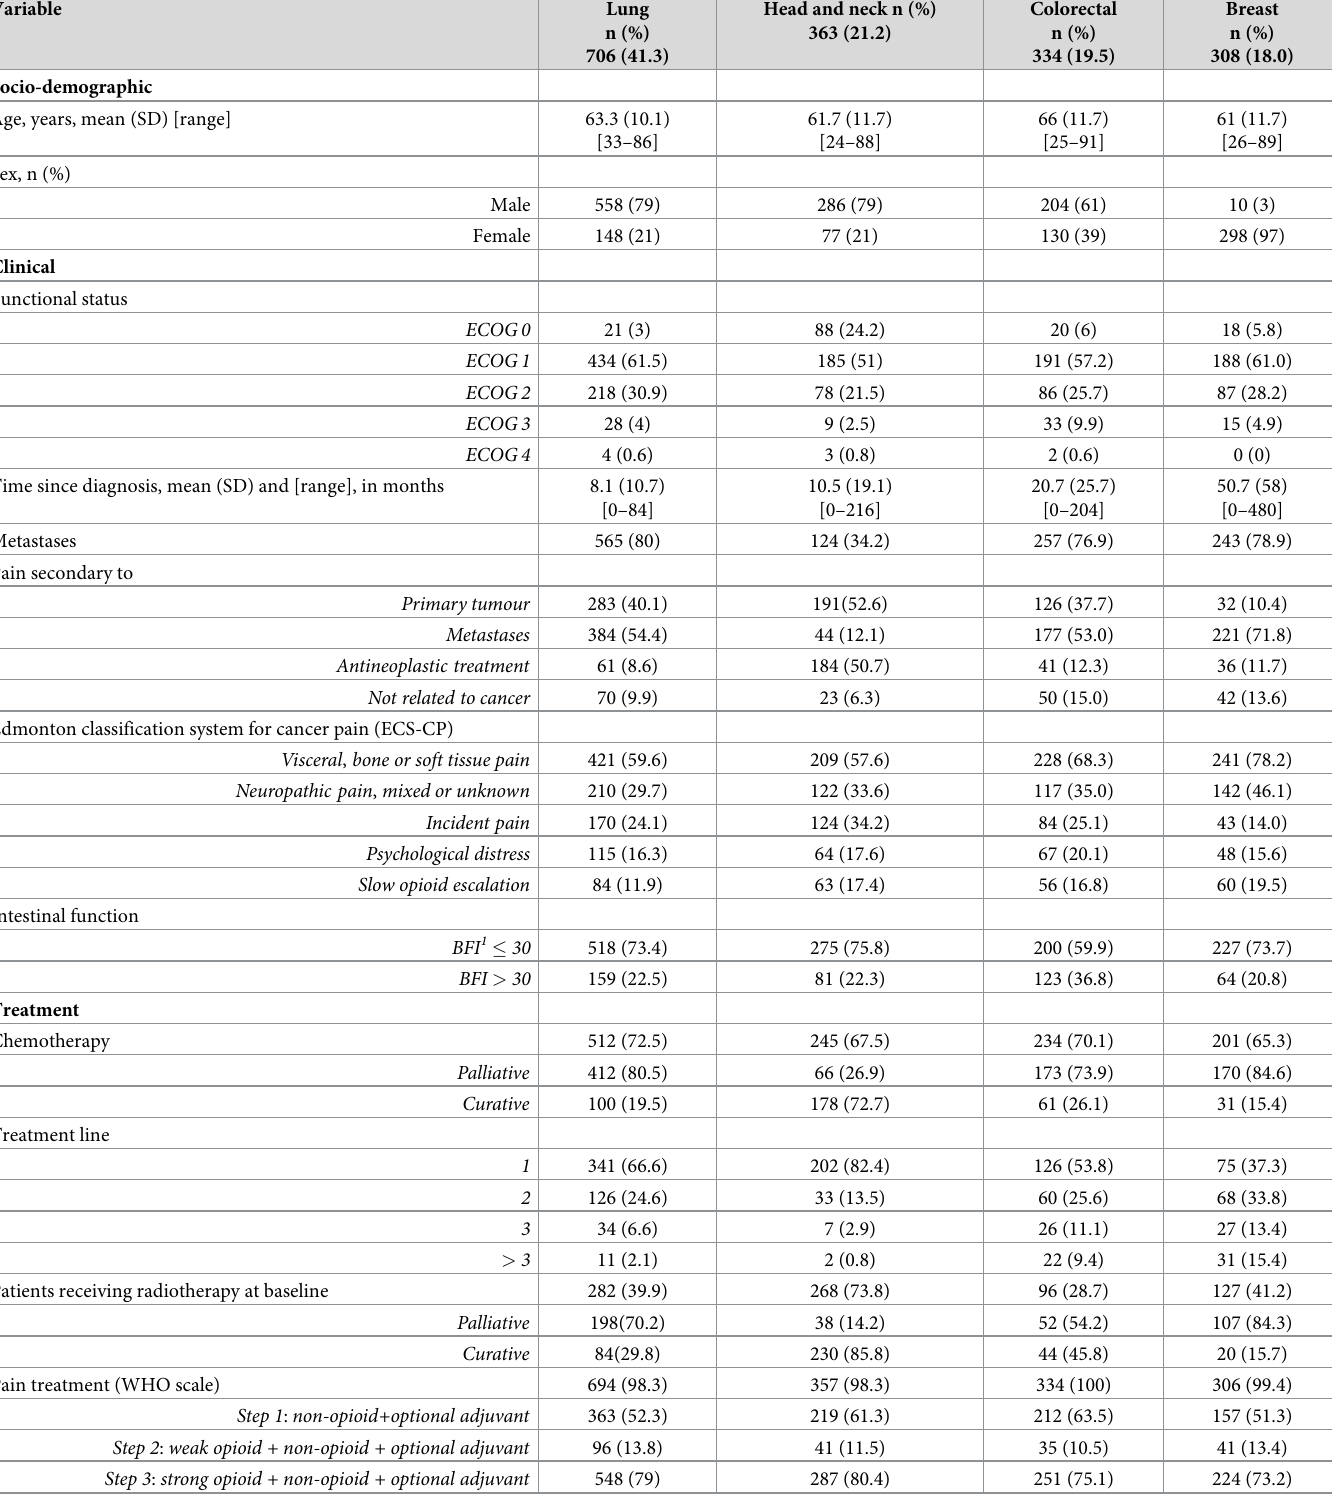
Table 1. Descriptive analysis showing baseline socio-demographic, clinical and treatment characteristics of the study population by cancer